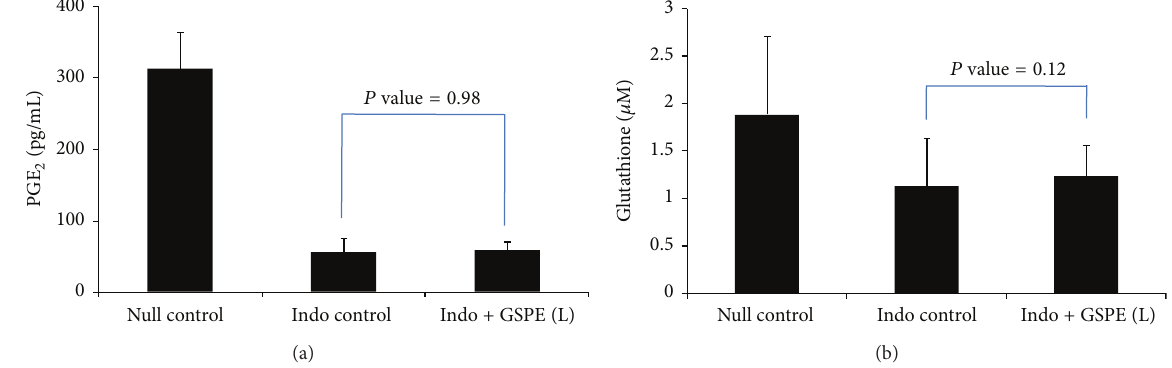
Figure 6: Tissue level of PGE 2 and glutathione. (a) The level of PGE 2 was 313.5 ± 51.9 pg/mL for the null control group, 55.6 ± 20.3 pg/mL for the indomethacin control group, and 58.6 ± 11.6 pg/mL for the GSPE low-dose group ( 𝑃 value = 0.983 ). (b) The tissue glutathione concentration was 1.98 ± 0.83 𝜇 M for the null control group, 1.13 ± 0.51 𝜇 M for the indomethacin control group, and 1.24 ± 0.32 𝜇 M for the GSPE low-dose group ( 𝑃 value = 0.12